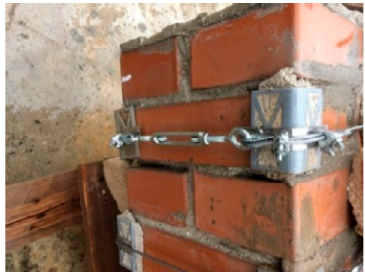
Figure 14. The fastening system along the lateral face of the brick wall (23 cm).